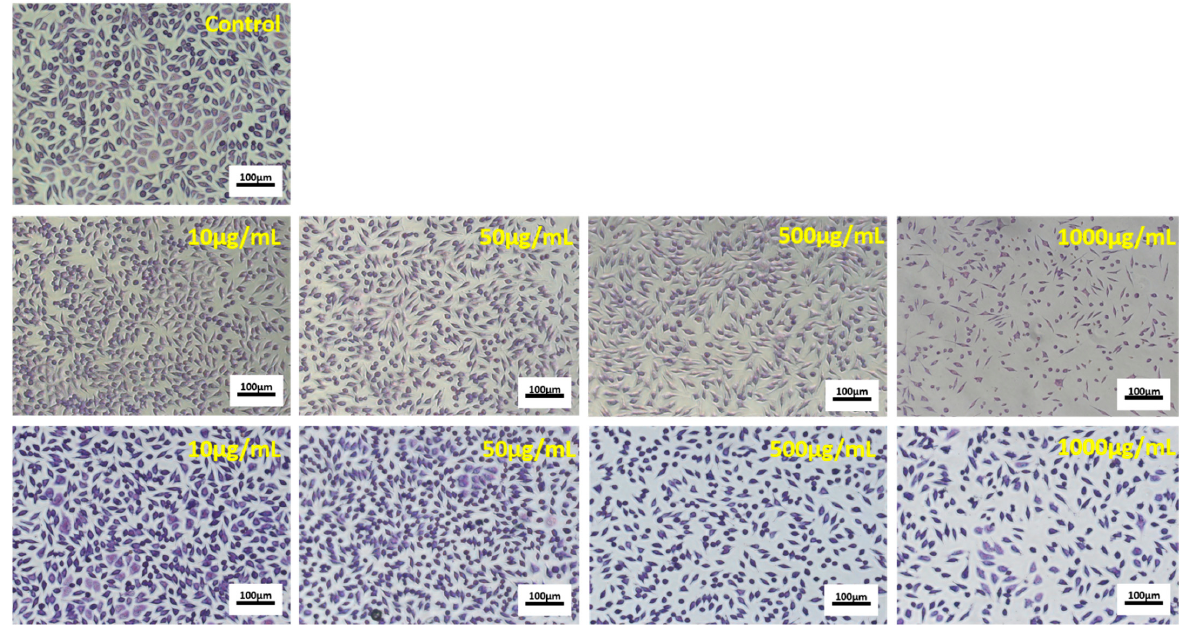
Figure 6. Representative light micrographs of L929 cells cultivated in the presence of different concentrations of P40 (second line) and P45 (third line) microencapsulated materials, for 48 h. The untreated culture served as control (first line). (Giemsa staining). Bar scale = 100 µm.